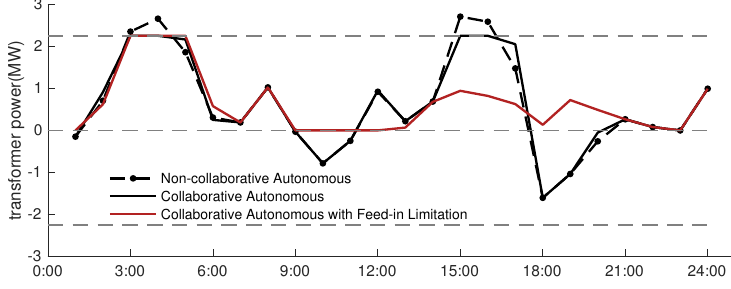
Figure 5. Transformer power under three operation